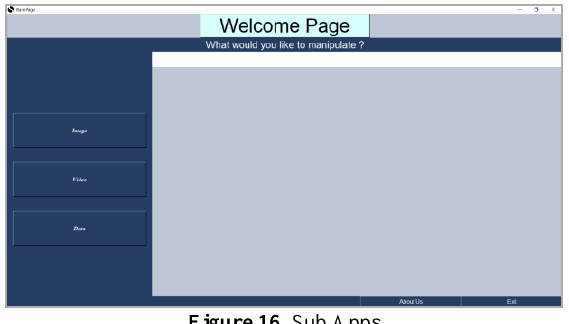
Figure 16 . Sub Apps